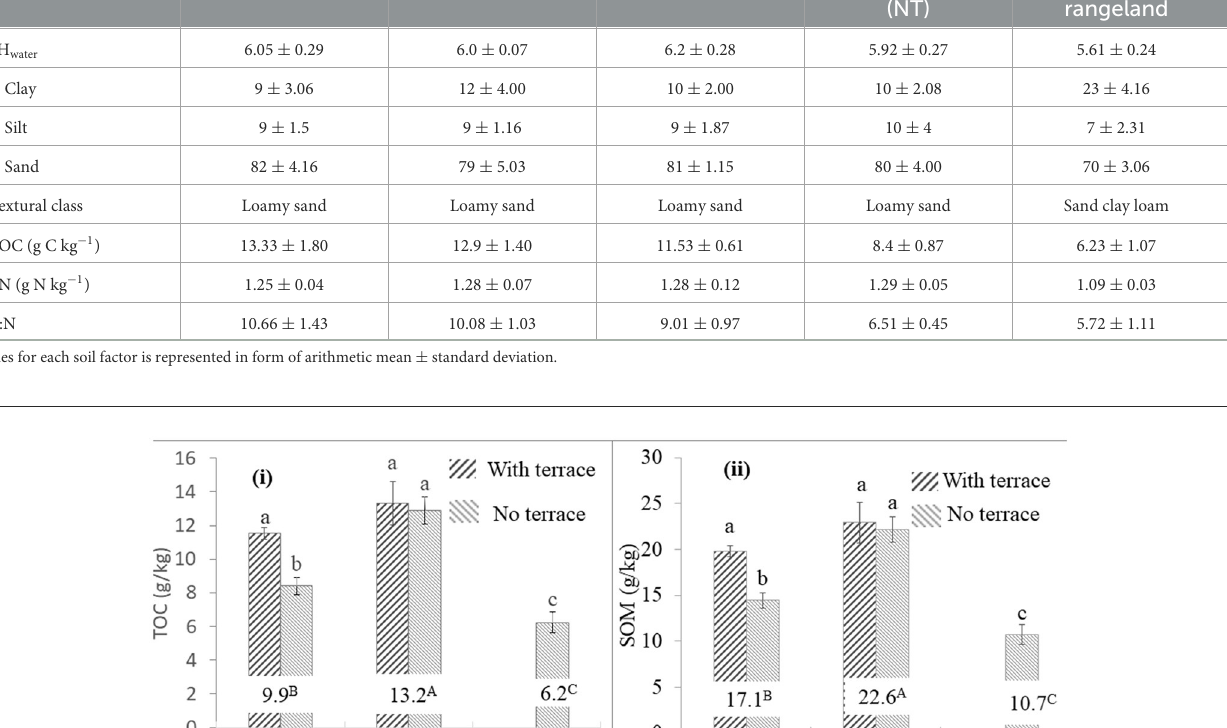
TABLE 1 Physico-chemical soil properties across selected soil conservation measures (T-with terrace, NT-without terraces). Soil factor